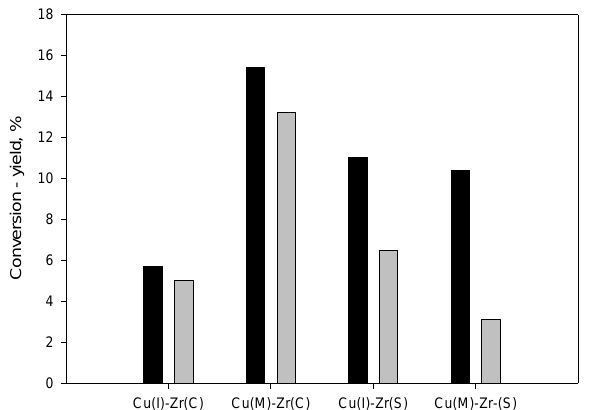
Figure 6. Glycerol conversion (black bars) and yield to 1,2-propanediol (gray bars) for the different catalysts. T = 240 °C; initial P = 20 bar(g); H 2 = 20 vol%; reaction time = 24 h; rotation speed = 500 rpm.